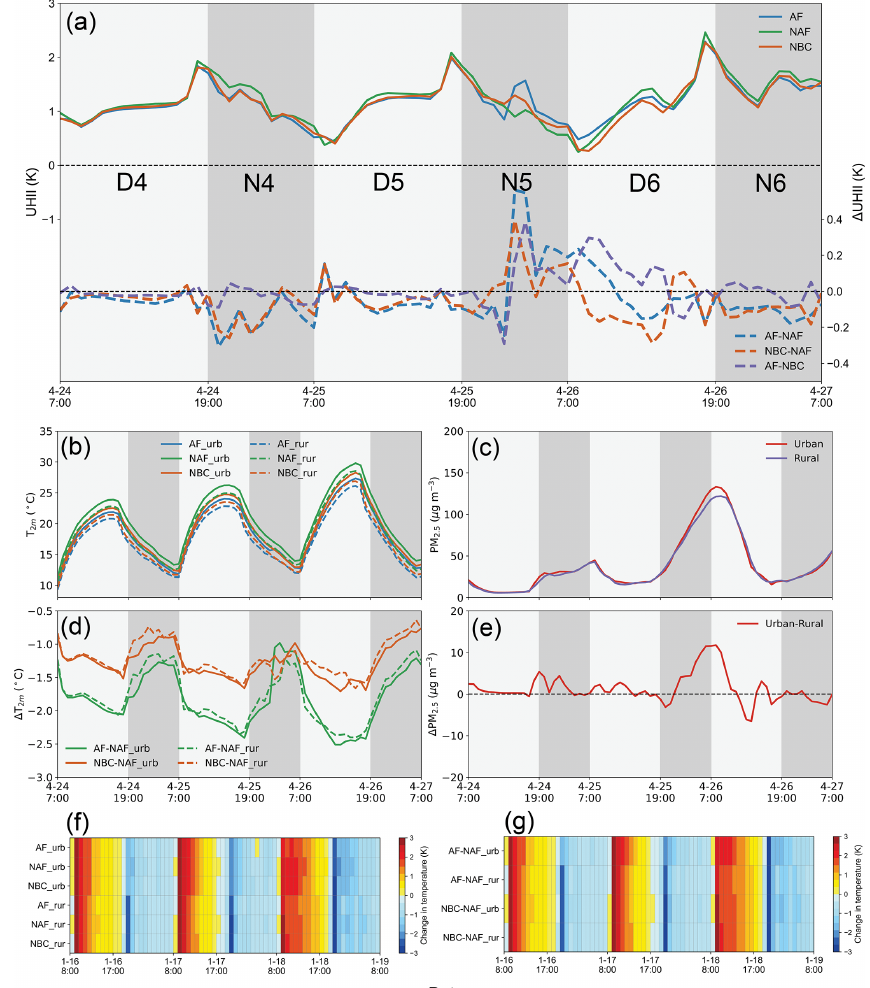
Figure 5. Same as Fig. 4 but for